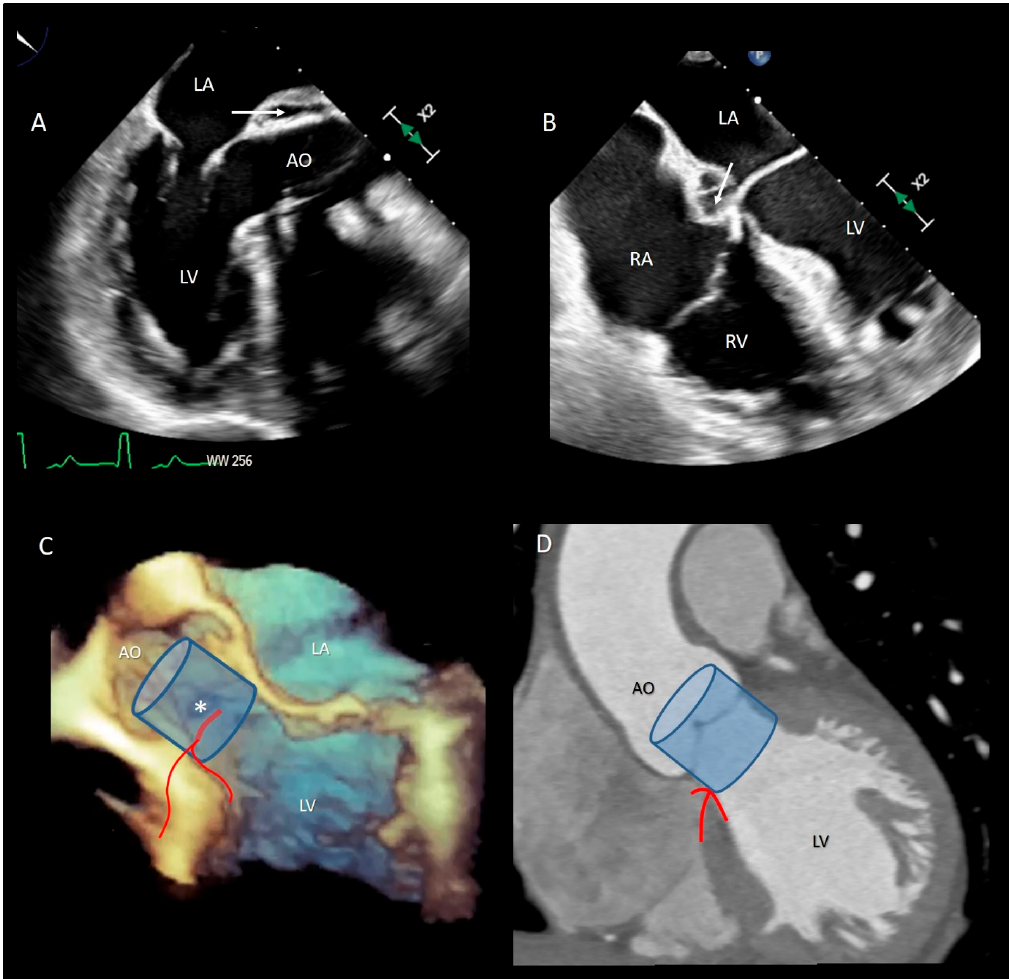
Figure 3. ( A ) The 2D TEE in long axis-view showing a peri-annular aortic abscess (arrow). ( B ) Same case of panel A showing the abscess may extend posteriorly on the crux cordis (arrow). ( C ) The 3D TEE in long-axis view. The red curve lines mark the position of His bundle immediately under the MS (asterisk) and its bifurcation. ( D ) CT multiplanar reconstruction showing the course of the His bundle and its branches (red lines). The light blue cylinders are representative of the position of the implanted valve. AO = aorta; LV = left ventricle; LA = left atrium; RA = right atrium; RV = right ventricle.